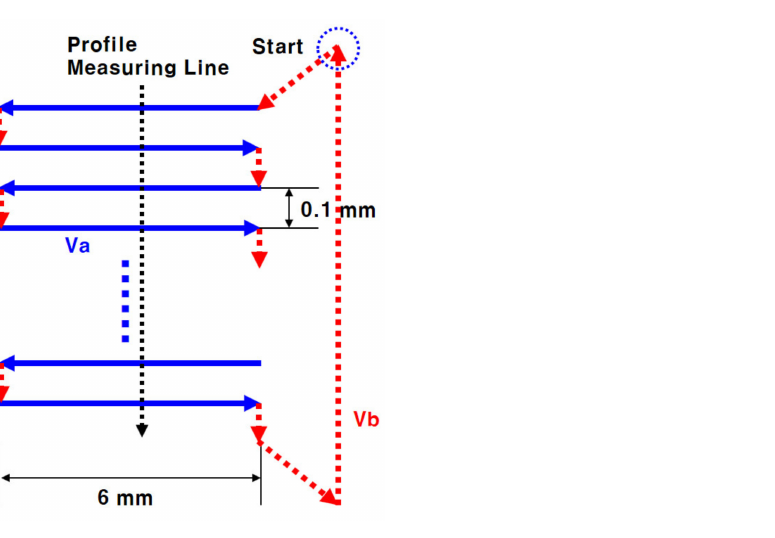
Figure 4. The 6 mm by 6 mm raster scan etch pattern and the profile measuring line (Vb = 8 · Vb).